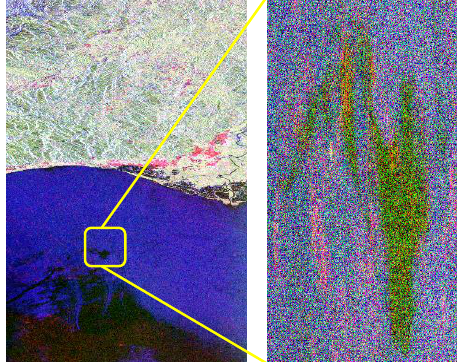
Figure 1. Pauli decomposition of study